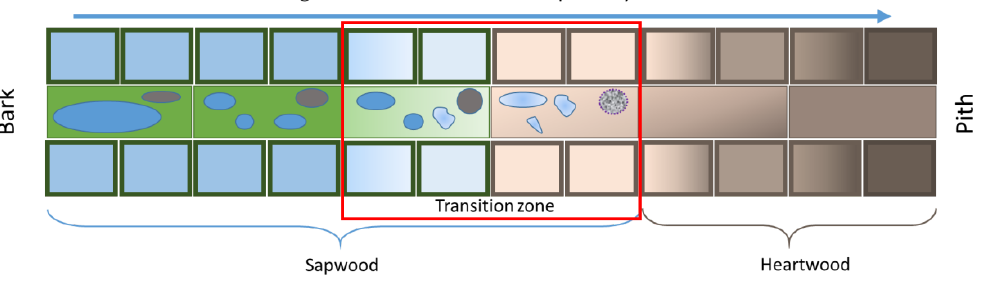
Figure 8. Scheme showing cytological changes in ray parenchyma cells as they move from the outer layers of SW to the PCD zone during HW formation. The outer layers of SW contain large central vacuoles and elliptical nuclei. As cells move toward the HW formation zone, the vacuoles are deformed and rounded nuclei then undergo degradation. The red box indicates the TZ.